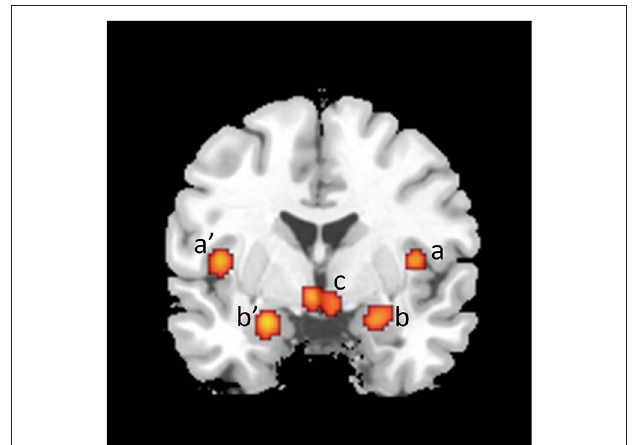
The participants are installed on the bed of the scanner.